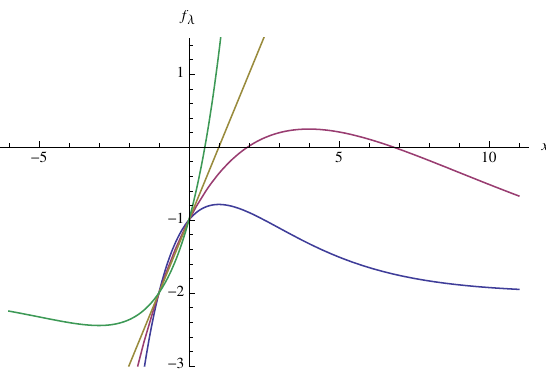
Figure 1 . Pro(cid:12)le of f (cid:21) ( x ) for (cid:21) = 0 : 5 (blue), (cid:21) = 0 : 2 (red), (cid:21) = 0 (yellow), and (cid:21) = (cid:0) 0 : 5 (green). In particular, (cid:21) = 0 : 5 has no real solution to f (cid:21) ( x ) = 0, which implies that there are no physical particle excitations around the tachyon vacuum. Also, (cid:21) = 0 : 2 has two real solutions. One of the two solutions has a negative gradient, which implies that the corresponding mode is a